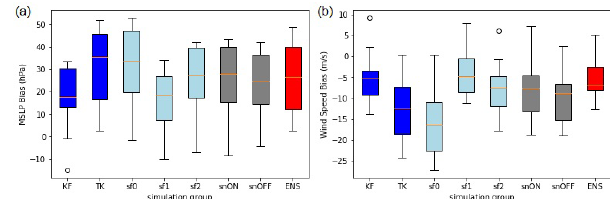
Figure 10. Mean biases for (a) minimum sea level pressure in hPa and (b) maximum winds in ms − 1 for each group of simulations: cumulus schemes KF and TK (blue bars), surface flux options (sf0, sf1, sf2) (light blue bars), spectral nudging ON and OFF (gray bars), and mean of the different experiments using four randomly selected EDA ensemble members (ENS) (red bars) as initial and boundary